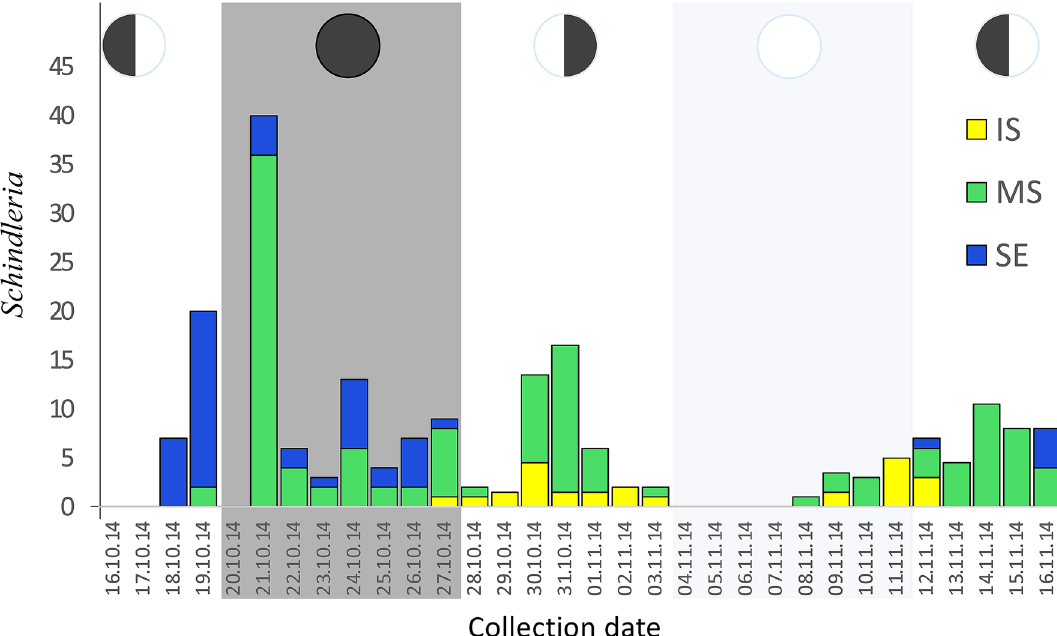
Figure 2. Barplot representing the total abundances of adult LDF Schindleria collected during one lunar cycle in the Red Sea of Saudi Arabia. The abundances of specimens (y-axis) are color-coded per sampling locations: from an inshore reef (IS) in “yellow”, from a reef at the mid-shelf (MS) in “green”, and from one at the shelf- edge (SE) in “blue”. Collections took place using three replicate LED powered light traps (collapsible Bellamare model) at each sampling location for the period of 32 consecutive nights, from the 16th October to the 16th November (2014; x-axis). Different moon phases are indicated with pie charts on the top of each shaded section of the plot starting with the 3rd quarter moon, followed by the new moon, the 1st quarter moon, the full moon, and ending again with the 3rd quarter moon (from left to